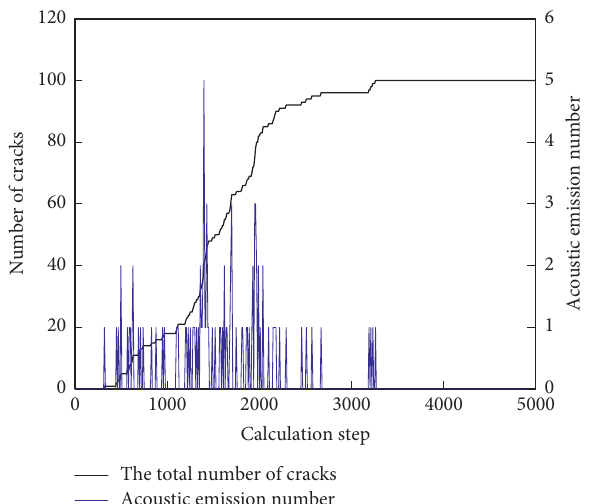
Figure 17: Developments in microcracks and acoustic emissions associated with deformation and failure of the coal roadway-sur- rounding